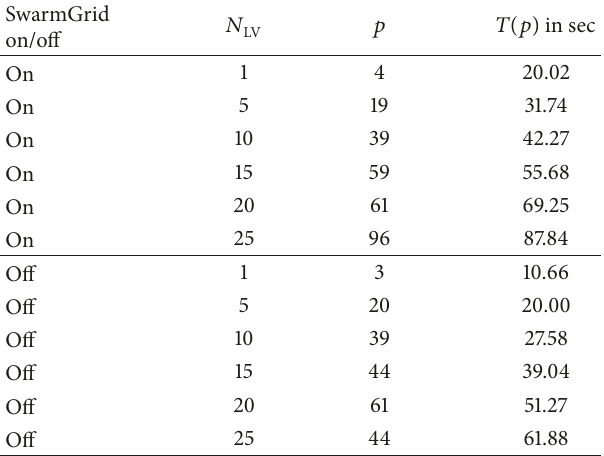
Figure 13: Scaling factors of scenario size in relation to scaling factors of minimal simulation execution time 𝑇(𝑝)